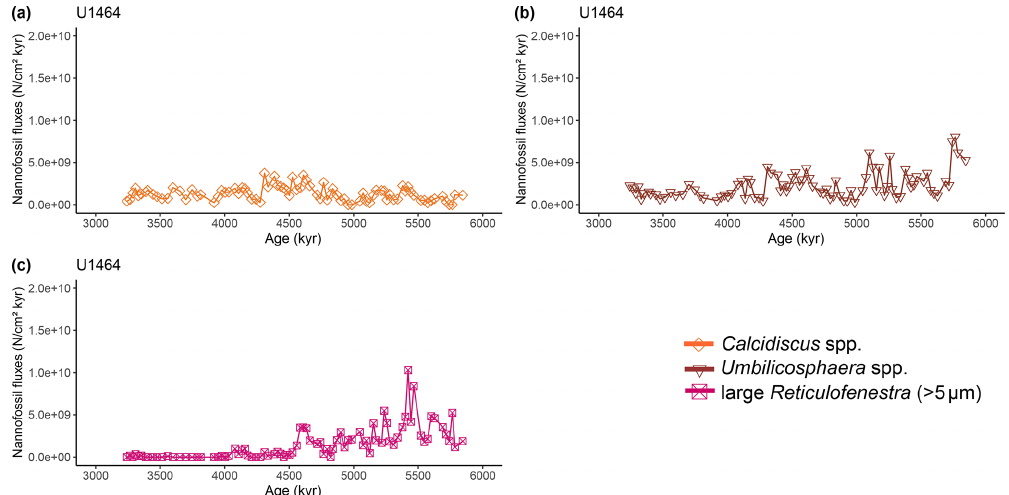
Figure A8. Latest Miocene to early Pliocene nannofossil fluxes (NAR; Ncm − 2 kyr − 1 ) of commonly occurring calcareous nannofossil species at IODP Site U1464. (a) Calcidiscus spp. (orange diamonds), (b) Umbilicosphaera spp. (brown triangles), and (c) large ( > 5µm) Reticulofenestra (purple-pink squares). Error bars of maximum replication error ( ± 15%; Bordiga et al., 2015) were too small and therefore impaired the visual inspection of the figure. However, they are available as part of the source data of this paper.